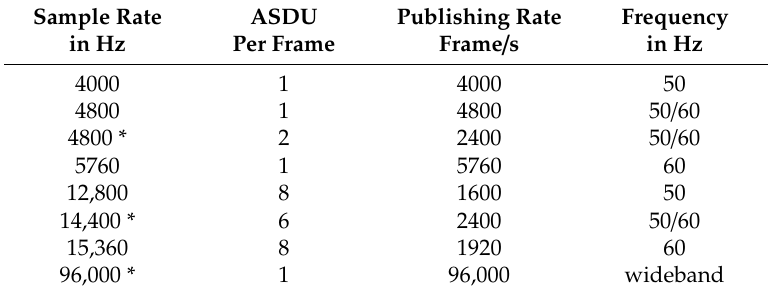
Table 1. The standard sample rates for the SV-based instruments according to the standard